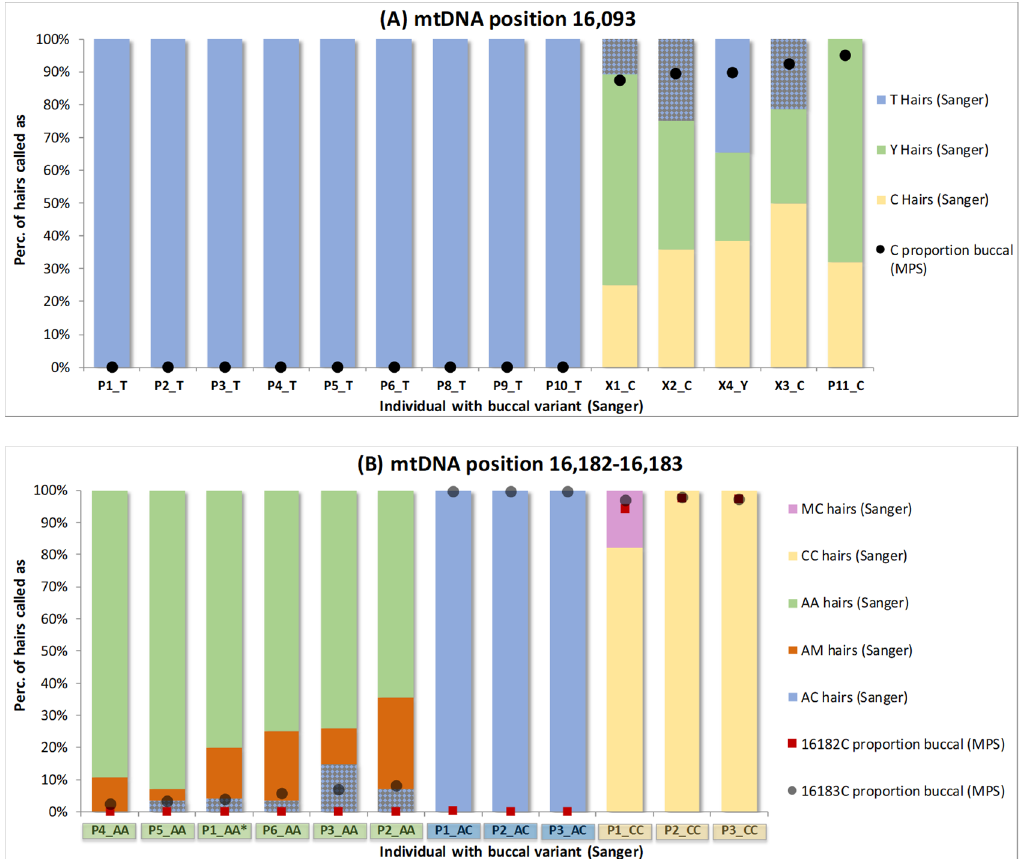
Figure 2. Overview of the percentage of hairs typed as specific genotypes (by Sanger) and the Sanger and Massively Parallel Sequencing results for the corresponding buccal reference. Two locations are regarded: position 16,093 ( A ) and positions 16,182 and 16,183 as a group ( B ). The MPS buccal levels of 16093C, 16182C and 16183C are marked as dots. For each individual, the Sanger call for the buccal reference sample is displayed after the sample name with a colour coding alike the hair. Sample naming is according to Supplementary Table S1 and [4,7] (* except for P1_AA which is the same sample as P5 in ( A )) and involves 25 different persons: 14 in ( A ) and 12 in ( B ). The bars representing hairs that exhibit a mismatch with the respective buccal (by Sanger) are filled with a pattern (grey blocks).